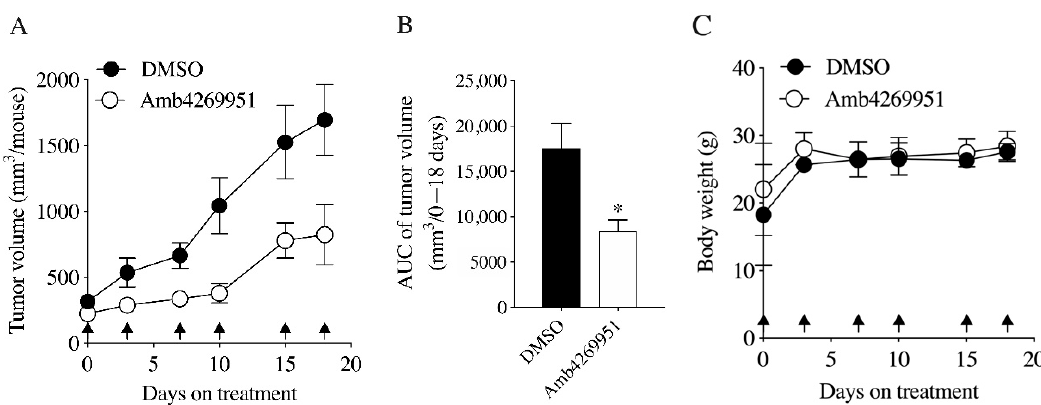
Figure 7. E ff ect of Amb4269951 on U251MG xenograft tumor progression and body weight. ( A ) The tumor volume was measured after intraperitoneal administration of 10 mg / kg Amb4269951 ( n = 5) and the vehicle control with DMSO ( n = 5). The date of administration is indicated by an arrow. ( B ) The Amb4269951 group significantly reduced xenograft tumor growth compared to the DMSO group (* p < 0.05). ( C ) The body weight of mice was measured at the time of drug administration. Data are represented as the mean ± SD ( n = 5).